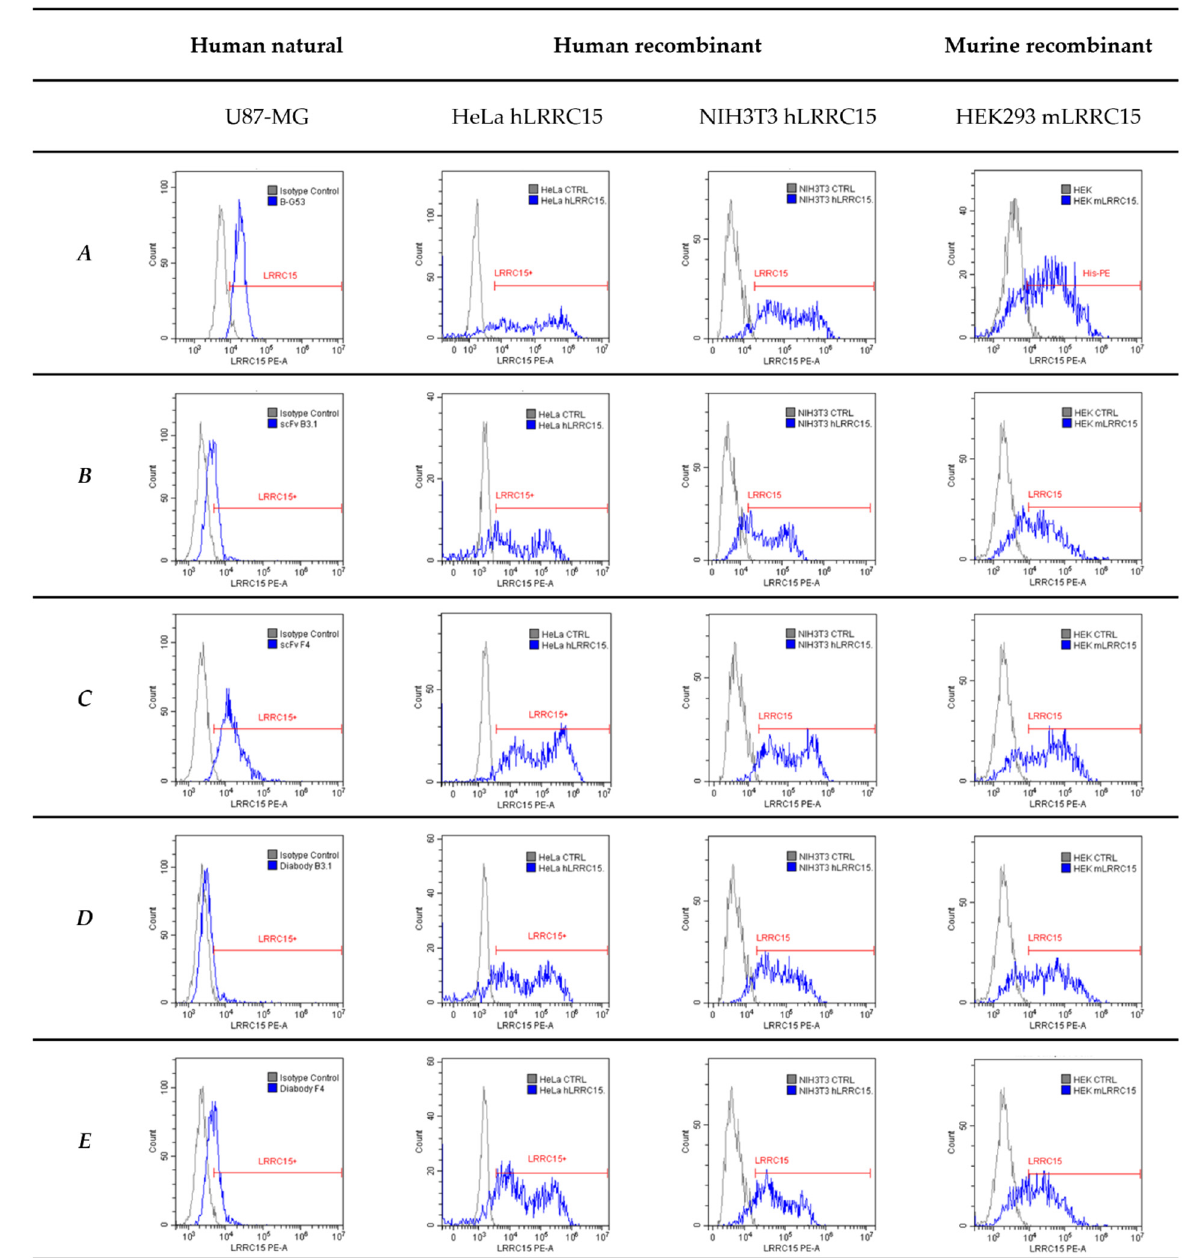
Figure 4. LRRC15 specificity analyses of fragments developed by FC on the U87-MG cell line, hLRRC15 transfected HeLa and NIH3T3, and mLRRC15-transfected HEK293. ( A ) Monitoring of LRRC15 expression with biotinylated anti-hLRRC15 B-G53 antibody or with anti-6xHis-Tag-PE. ( B ) B3.1 Cys-ScFv, biotinylated. ( C ) F4 Cys-ScFv, biotinylated. ( D ) B3.1 Cys-Db, biotinylated. ( E ) F4 Cys-Db, biotinylated. All biotinylated items were revealed with streptavidin-PE. The F4 candidates showed higher labeling compared with the B3.1 candidates (Cys-ScFv or Cys-Db) on the natural cell